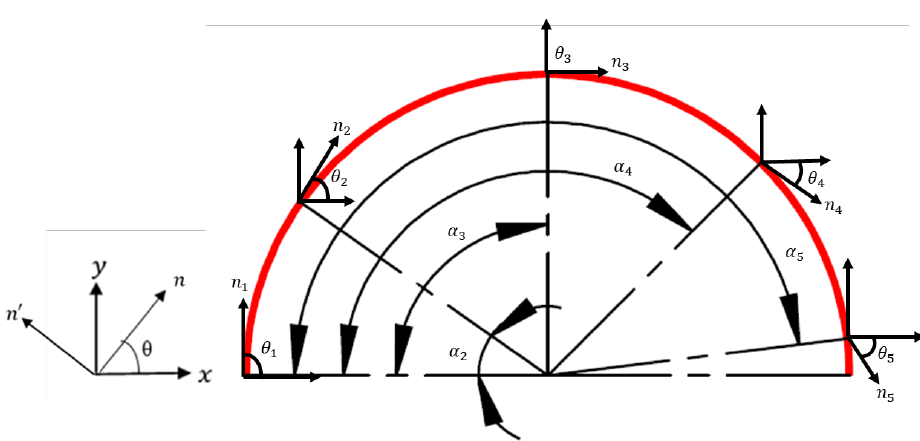
Figure 4. Schematic illustration of the semicircular geometry used in this study for strain transformation.